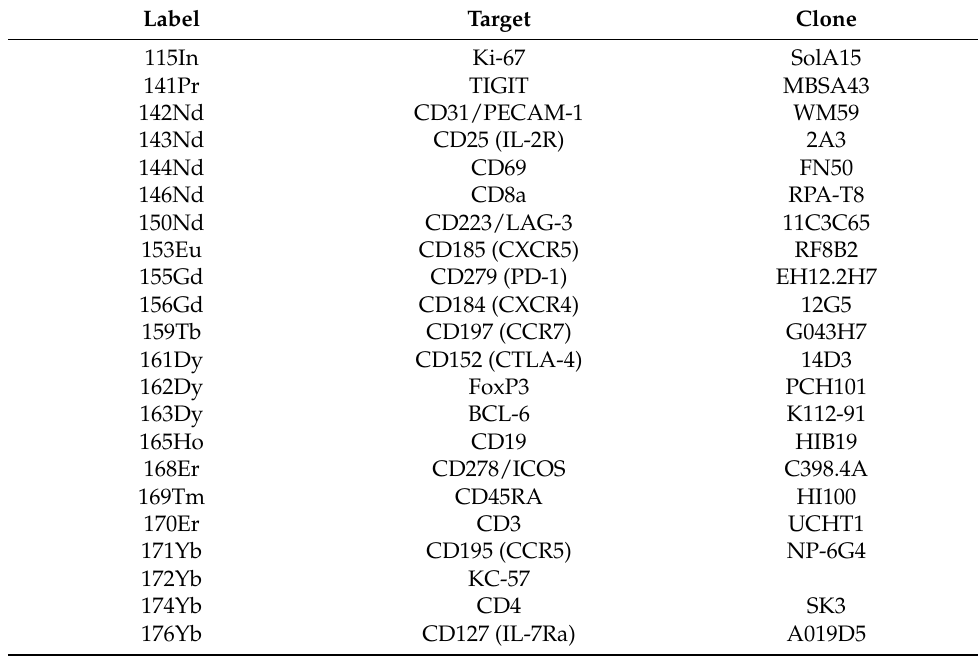
Table 2. CYTOF metal-isotype conjugated